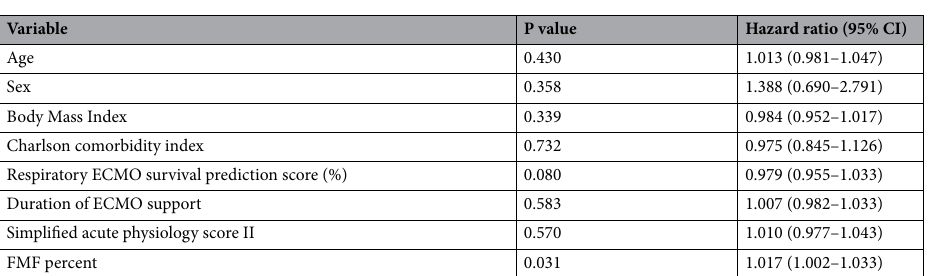
Table 2. Multivariable risk factor analysis for 1-year mortality. A multivariable logistic regression model was built to test the impact of clinical variables on 1-year mortality. FMF was included as a continuous variable alongside with a set of a priori selected covariates, which were judged reasonable based on previous literature and clinical perception. Results are displayed as adjusted hazard ratio (HR) with 95% confidence interval (CI). The level of statistical significance was set to P < 0.05. In this analysis, FMF was identified as a risk factor for 1-year mortality following ECMO, independent of anthropometric parameters (age, sex, BMI), duration of ECMO support, severe systemic comorbidities (Charlson comorbidity index), severity of disease (Simplified Acute Physiology Score II), and clinical risk stratification (Respiratory ECMO Survival Prediction Score). ECMO Extracorporal Membrane Oxygenation, FMF Fatty Muscle